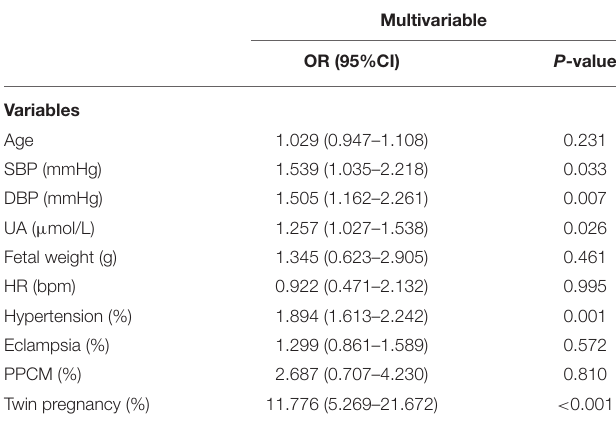
TABLE 6 | Multivariable logistic regression analysis indicated risk factors significantly correlated with severe QTc prolongation in parturient women.